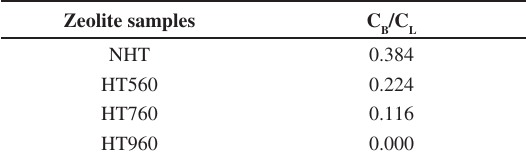
Figure 8. FTIR spectra of the adsorbed pyridine in the 1577-1400 cm –1 range after pyridine desorption at 200 °C of zeolite samples NHT, HT560, HT760 and HT960. Table 2. Decrease of Brönsted to Lewis C increasing temperature of the hydrothermal treatment. Zeolite samples